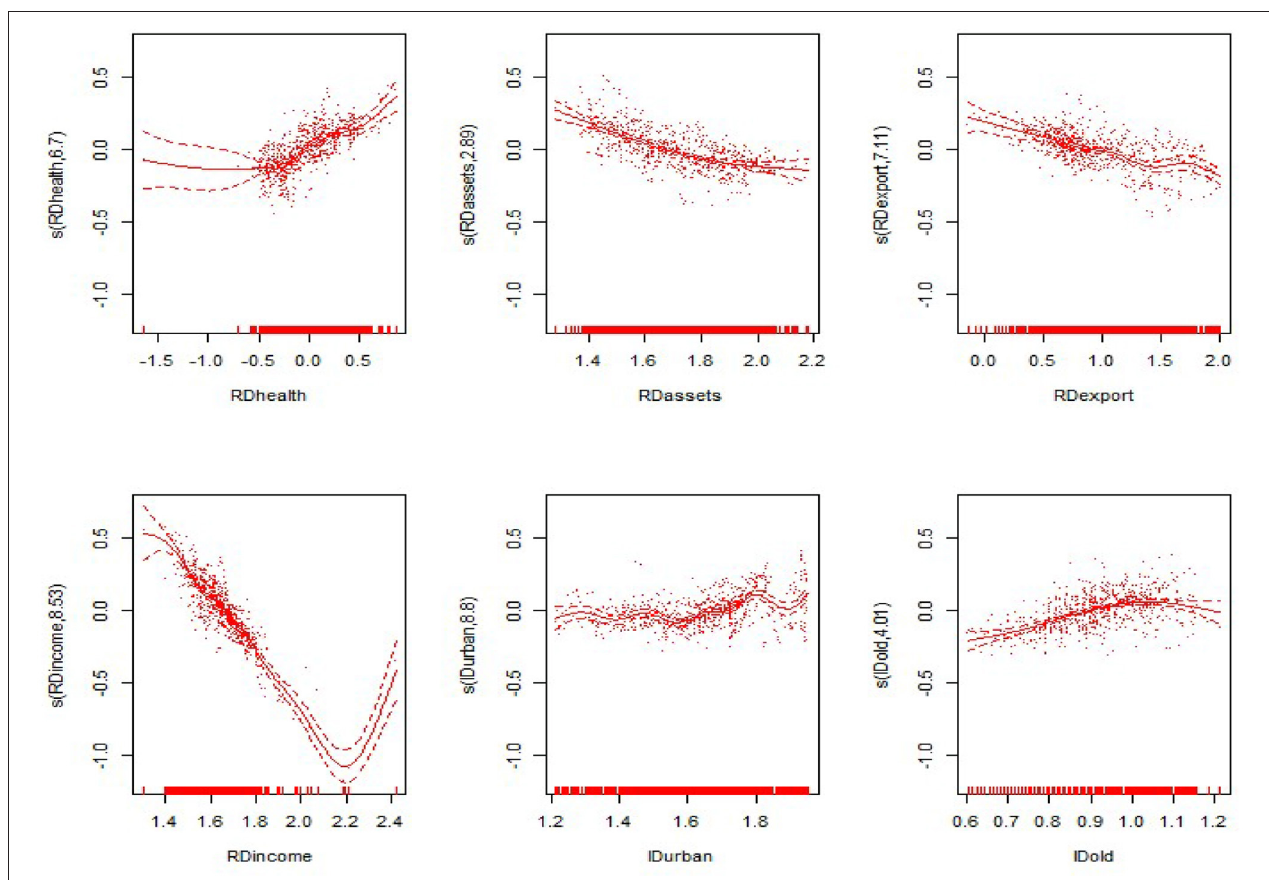
FIGURE 3 | Non-linear effects of the explanatory variables on per capita GDP in the nation.